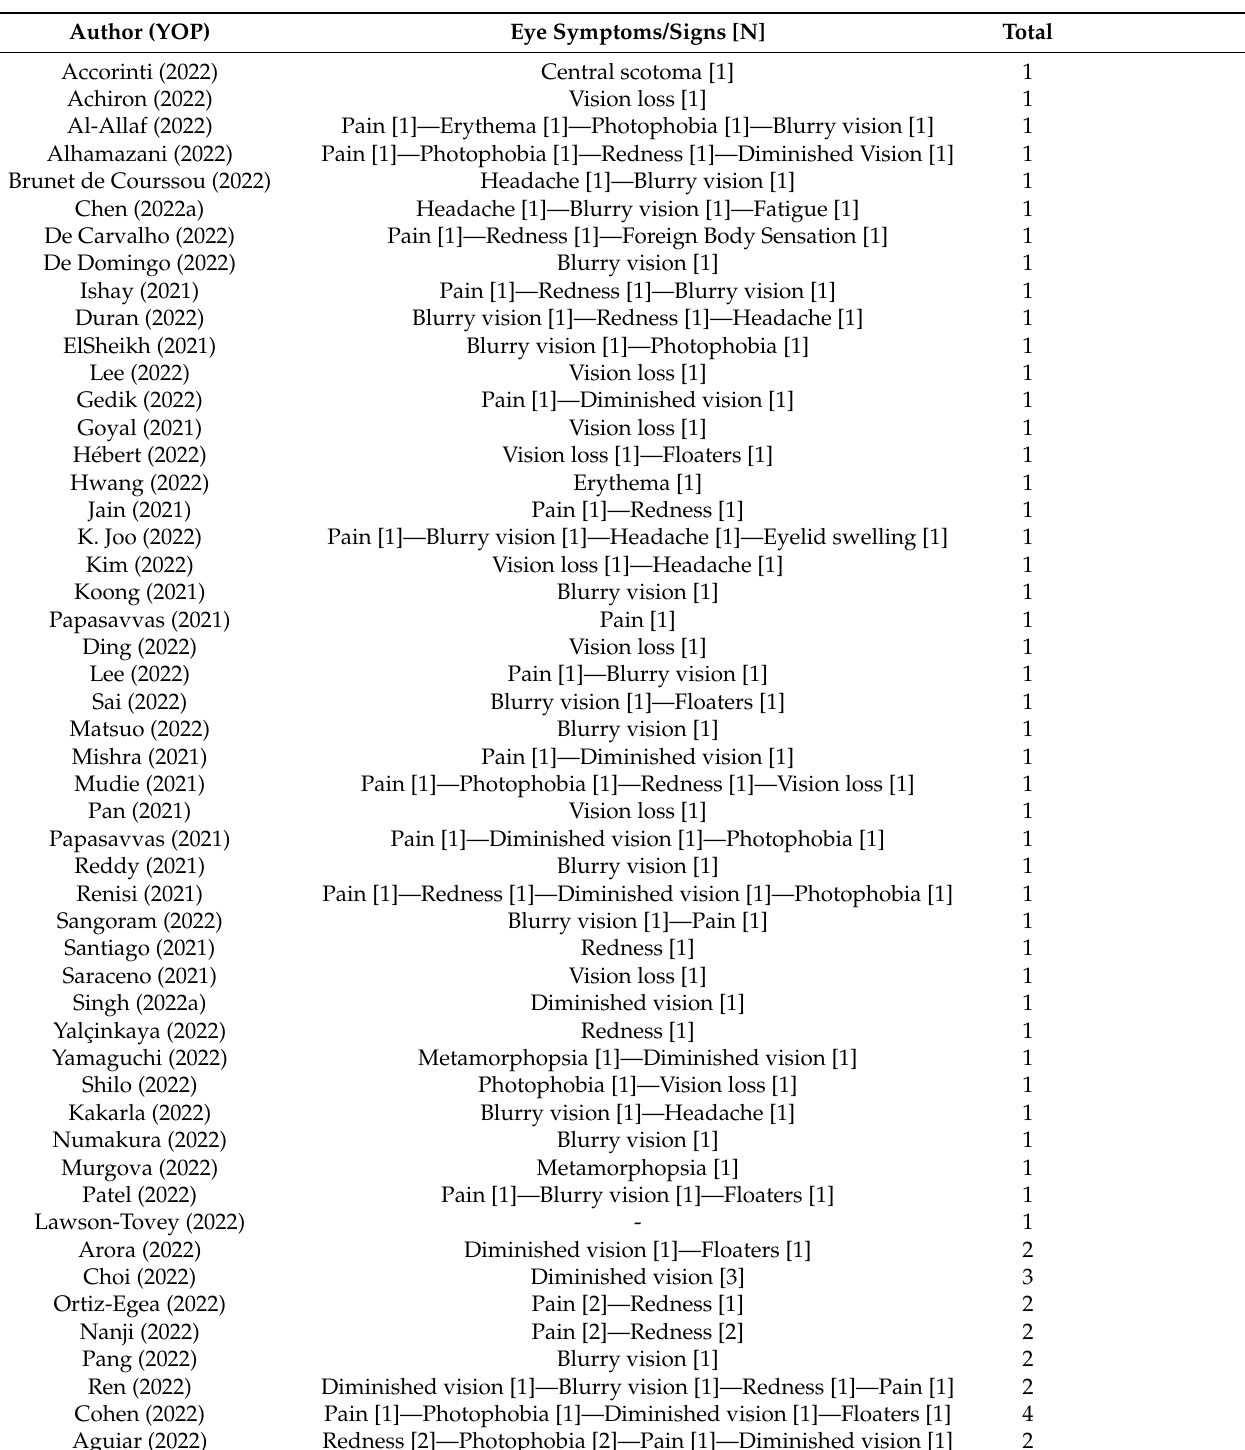
Table 4. The clinical presentation of COVID-19 vaccine-associated